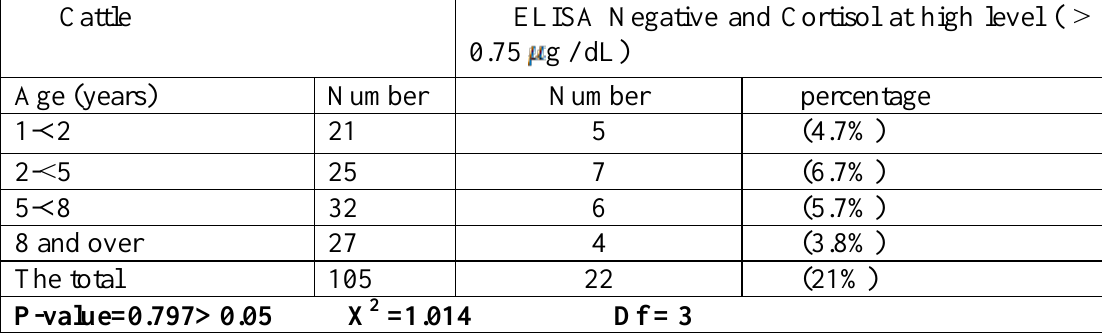
Table (7): The fifth Group, ELISA Negative and Cortisol at high level Cattle ELISA Negative and Cortisol at high level ( <